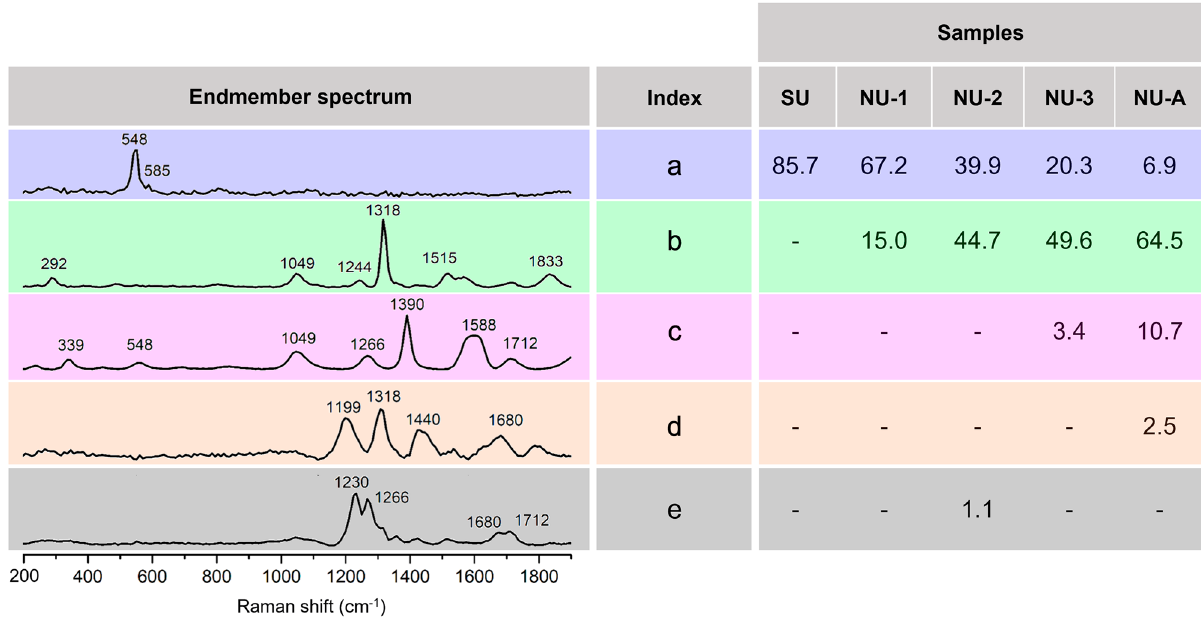
Figure 5. Raman endmembers ( a – e ) obtained from the VCA of pigment samples and their respective contributions (%) to the total number of pixels of each sample. The areas of the labelled bands correspond to Raman SPDCs included in the multisensor